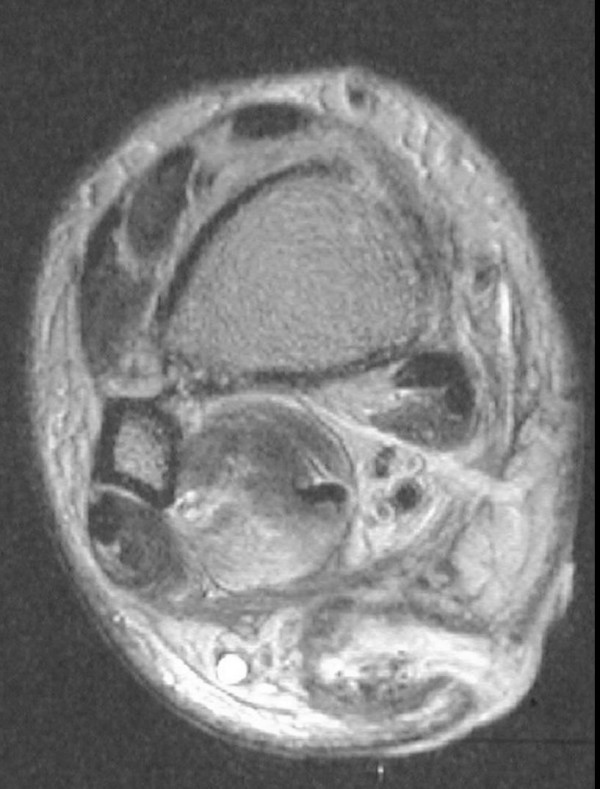
MRI scan at presentation, cross sectional view at the level of the upper end of the distal stump of the Achilles tendon. Note the disruption of the medial cortex of the tibia, indicating the presence of a fracture in that area.